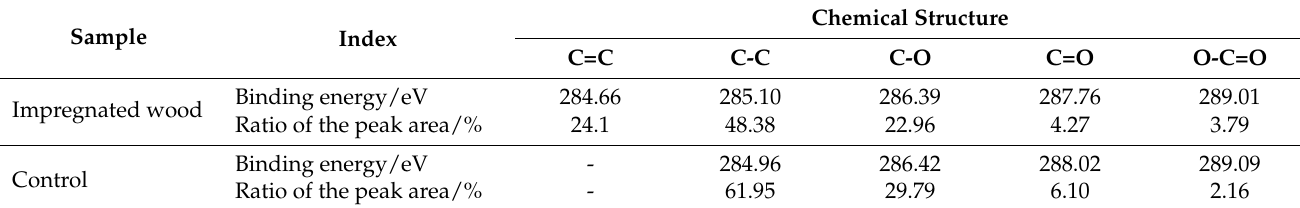
Figure 9. XPS spectra of shellac and Chinese fir impregnated with shellac solution under vacuum: ( a ) full spectrum of shellac; ( b ) C1s spectrum of shellac; ( c ) the full spectrum of the control wood sample; ( d ) C1s spectrum of the control wood sample; ( e ) the full spectrum of the impregnated wood sample; ( f ) C1s spectrum of the impregnated wood sample. Table 6. The ratio of chemical structure and C1s peak of the wood impregnated with shellac solu- tion.